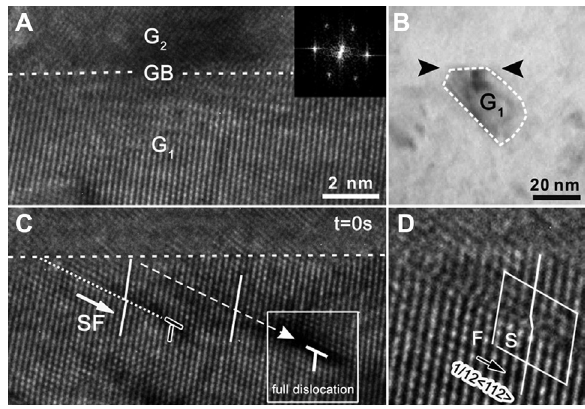
Figure 1 In situ transmission electron microscopy (TEM) observations of partial and full dislocations in nanocrystalline Ni. (A) A high-resolution TEM image of a grain (G ) with no preexisting 1 dislocation before tensile loading. The inset shows the fast Fourier transform pattern of G . The grain boundary between G and its 1 1 adjacent grain (G ) is marked by a white dashed line. (B) Low- 2 magnification image of the grain G with the outlined boundary. Two 1 arrows indicate the grain boundary between G and G , as shown 1 2 in (A). (C) After loading, a partial dislocation and a full dislocation, marked by black “T” and white “T,” respectively, nucleated from the grain boundary and then propagated into the interior of G . The 1 (111) slip planes are indicated by dashed white lines. The stacking fault (SF) left behind the partial dislocation is marked by the dotted-dashed line. (D) A magnified high-resolution TEM image of the partial dislocation during recovering. The stacking fault is indicated by a fold line. Reprinted from [12]. Copyright 2010, with permission from the American Institute of